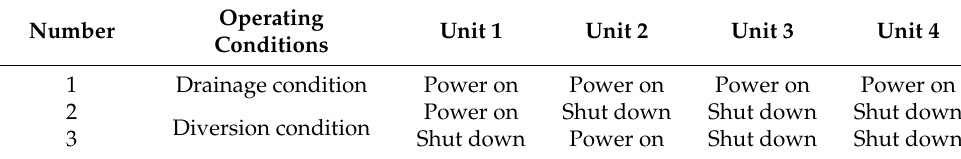
Table 2. Unit startup